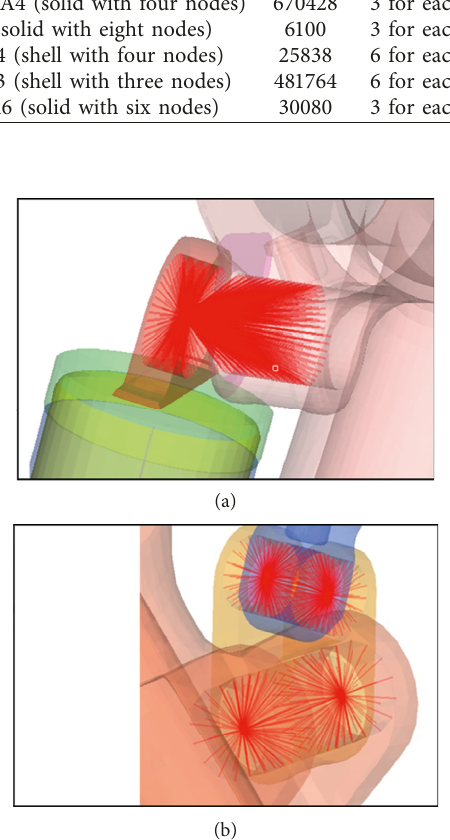
Figure 12: (a) Spherical and (b) cylindrical joints.